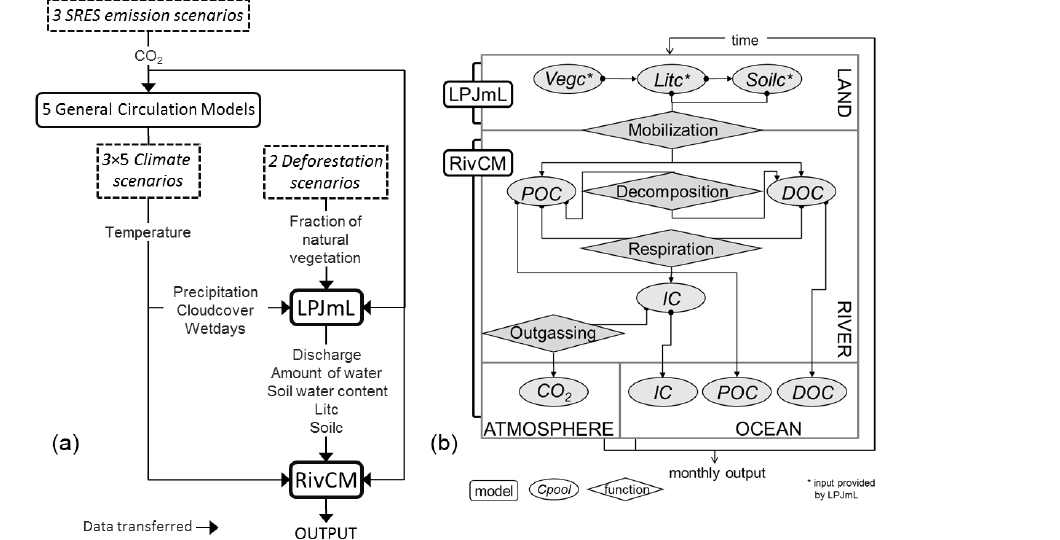
Figure 1. Overview of the general transfer of data between scenarios and models (a) and the detailed calculation of carbon fluxes within and between LPJmL and RivCM. (b) . Table 1. Location and characteristics of the three subregions. North-west South-east Area Changes in Changes Land use corner